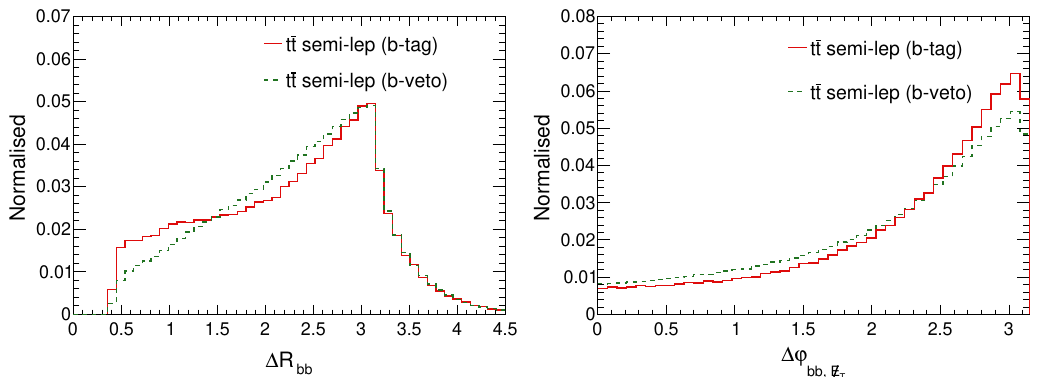
Figure 18. The comparison between the normalised distributions of ∆ R bb (left) and ∆ φ (right panel) for t ¯ t semi-leptonic background in the b-veto and b-tag category of b ¯ b + /E